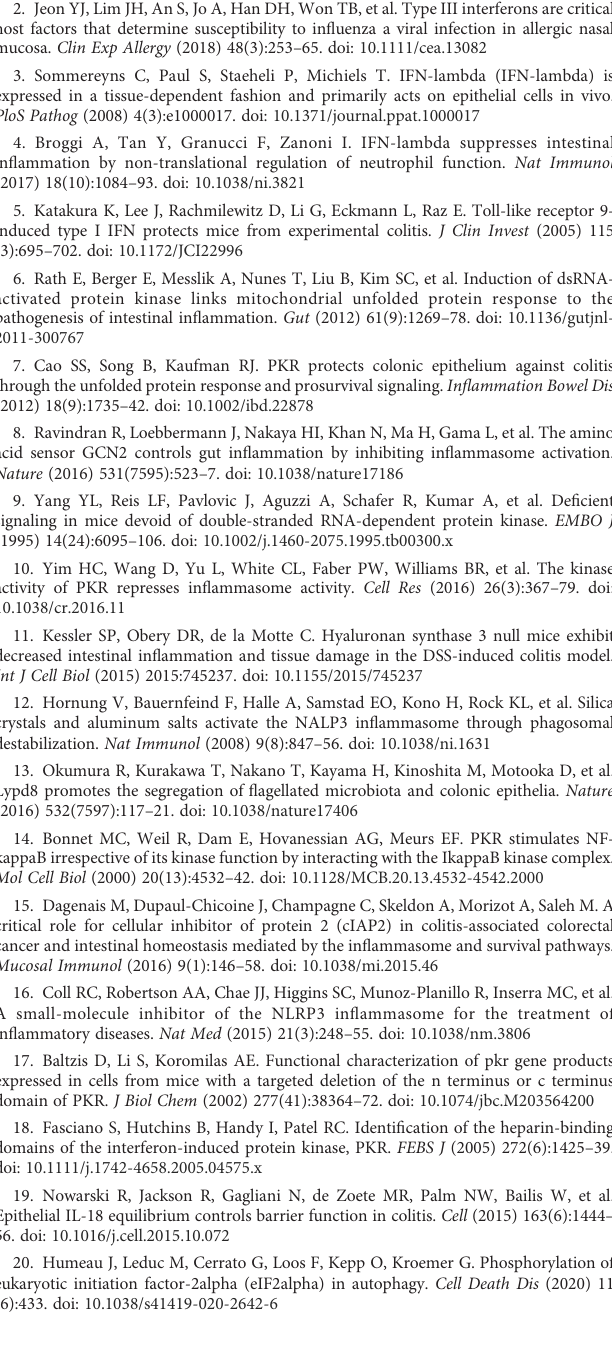
SUPPLEMENTARY FIGURE 2 A comparison of proteins between the different PKR genotypes. Immunoblots comparing the relative expression of the indicated proteins between spleen cells from mice either untreated of treated with DSS (n=3) ( Eif2ak2 -/- and PKR- K271R symbolized as -/- and KR, respectively). Representative images from three independent experiments are shown.